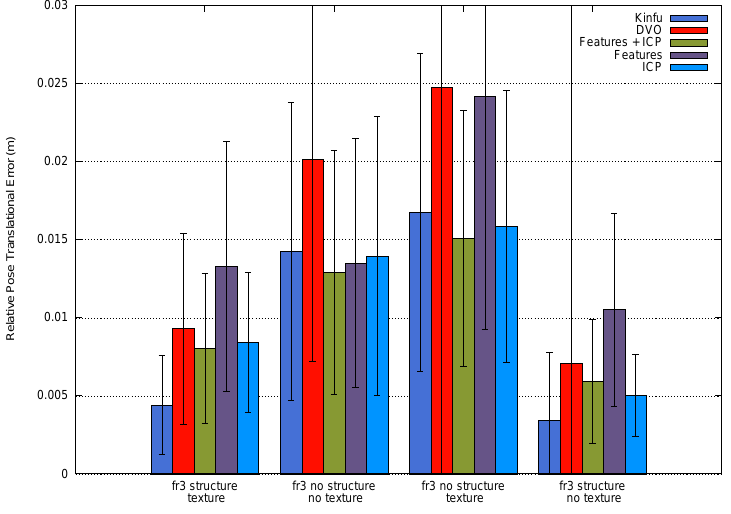
Figure 14. Error means (bars) and the standard deviations (error lines) of the five different methods applied to the different texture and structures